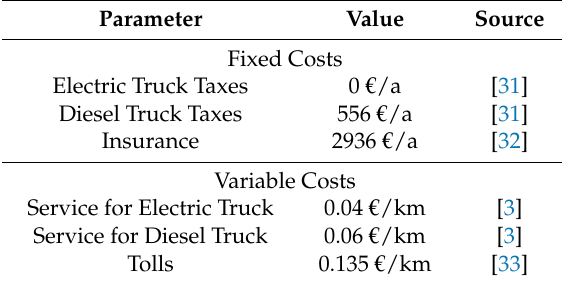
Table A5. Cost parameters for the fixed and variable